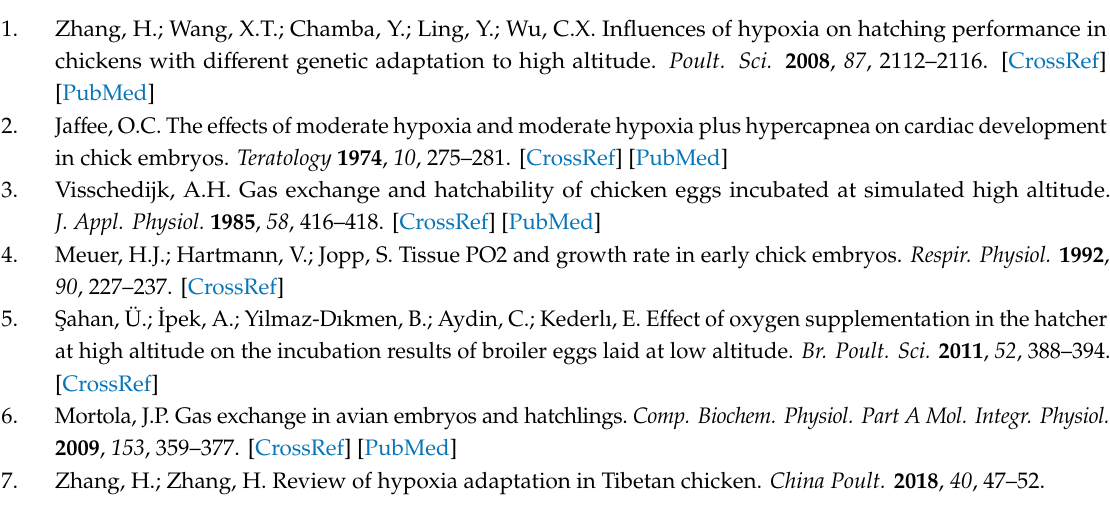
Table S1: Candidate genes identified by XPEHH test, Table S2: Candidate genes identified by Fst test, Table S3: Candidate genes identified by both XPEHH test and Fst test, Table S4: Di ff erentially expressed known genes (DEKGs) between the embryonic livers of the Tibet chicken and the lowland chicken, Table S5: Di ff erentially expressed known genes (DEKGs) between the embryonic hearts of the Tibet chicken and the lowland chicken, Table S6: Overlapping known di ff erent expression genes between livers and hearts of chicken embryos by RNA sequencing analyses, Table S7: Di ff erentially expressed unknown genes (DEUGs) between the Tibet chicken and the lowland chicken embryonic hearts and between their embryonic livers, Table S8: Overlapping known genes between the results of identification of signatures of selection and RNA sequencing